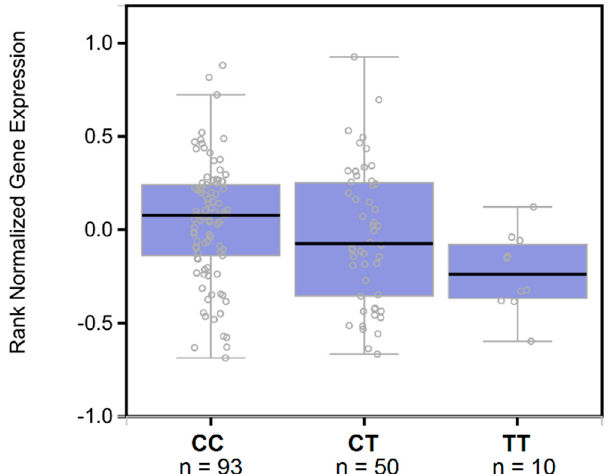
Figure 3. Expression quantitative trait loci box plots of associations between rs9957088 genotypes and hepatic TTR gene expression (data source: GTEx V7). The purple box plot shows ranked normalized gene expression in median, 1st and 3rd quartiles, and 1.5 interquartile range (IQR) of 1st and 3rd quartiles.